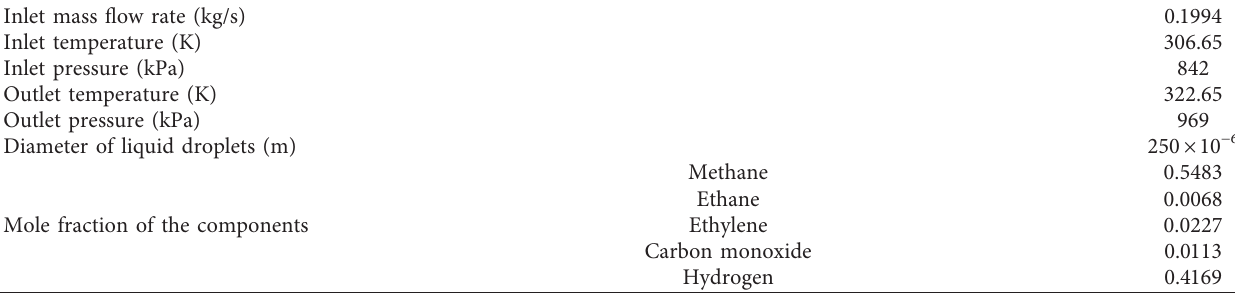
Figure 14: Velocity vector for (a) HP Compressor (b) LP Compressor. Table 6: Information on boundary conditions and models.